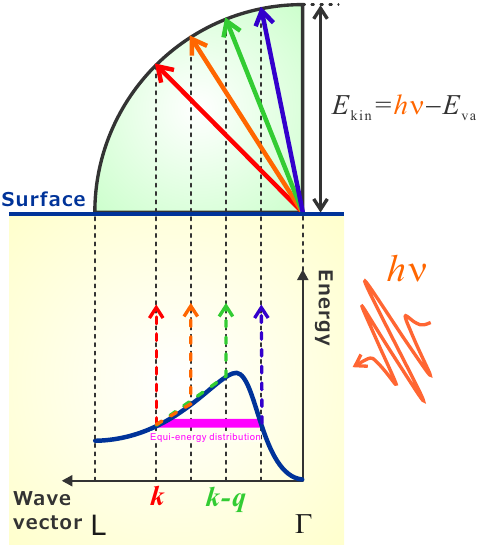
Figure 13. A schematic view of the initial state interaction in the photo-emission process of the L valley electrons. The colored arrows show some possible emission paths of a L valley electron, passing through the unoccupied states in the conduction band. For more details, see the text.